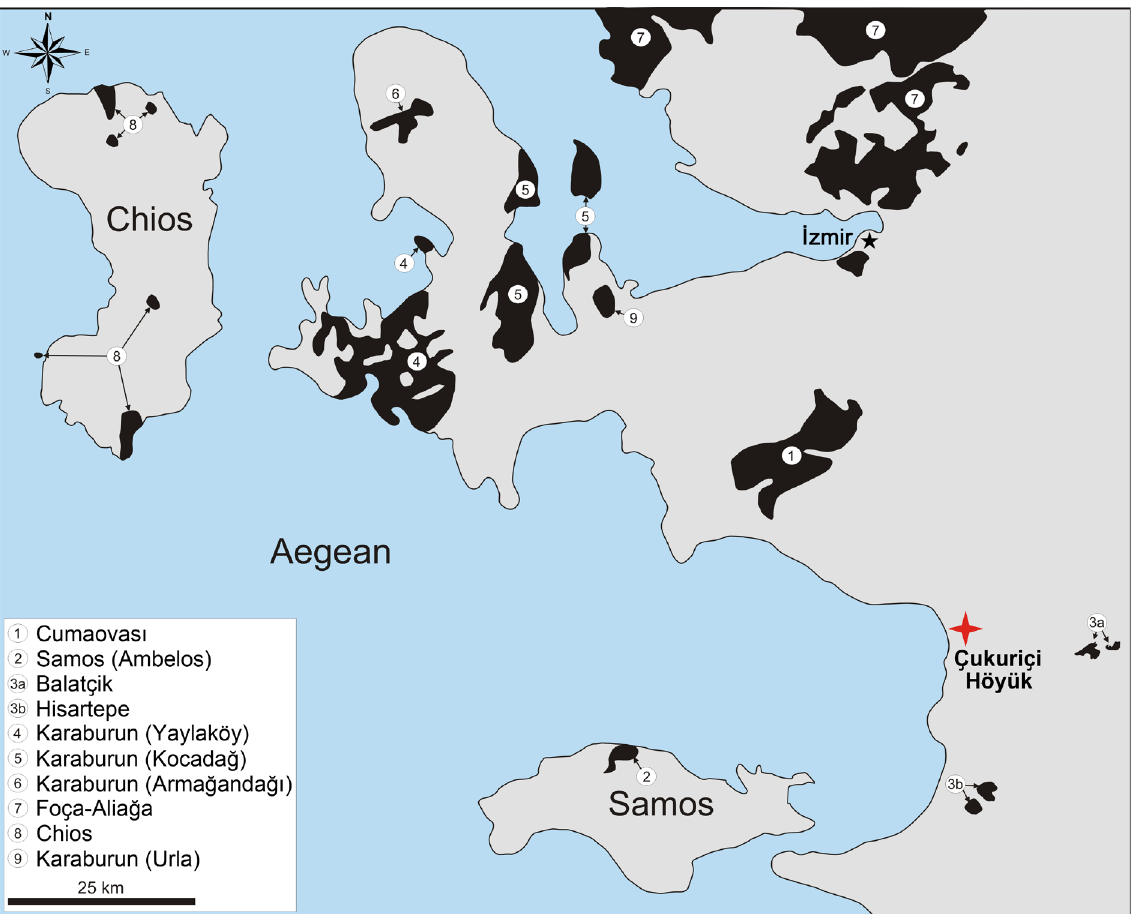
Figure 3. The closest volcanic rock sources in the surrounding area of Çukuriçi Höyük (map by D. Wolf based on Akay & Erdoğan 2004; Borsi et al . 1972; Ercan et al . 1986; Helvac ı et al . 2009; Innocenti & Mazzouli 1972; Pe-Piper & Piper